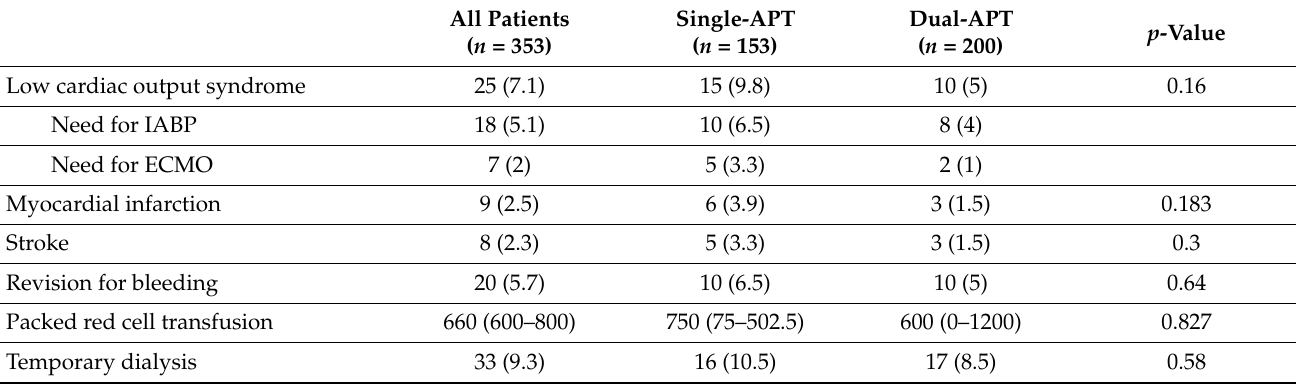
Table 3. Postoperative